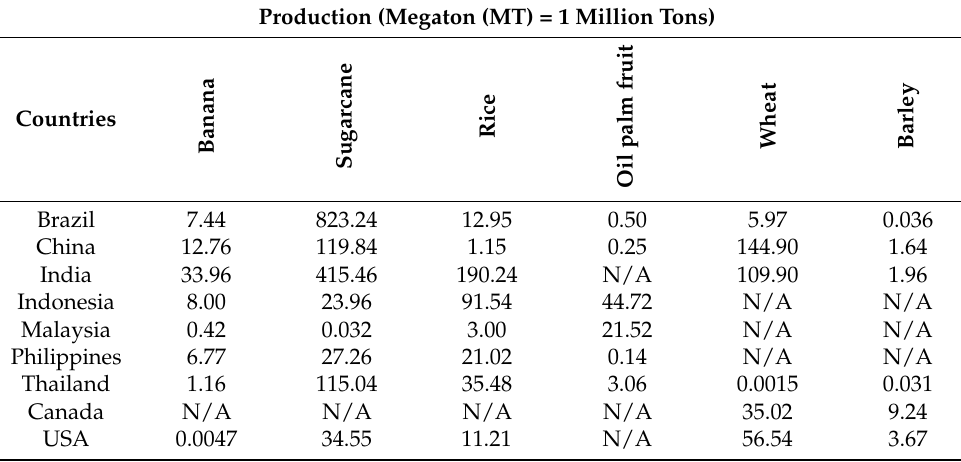
Table 3. Agricultural products as potential natural fiber resources